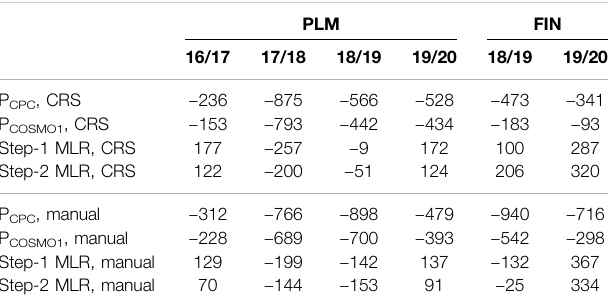
TABLE 3 | CombiPrecip, COSMO-1 precipitation, Step-1 MLR and Step-2 MLR mean bias errors [mm] with respect to CRS observations and manual measurements performed during the winter seasons on the Plaine Morte and Findel